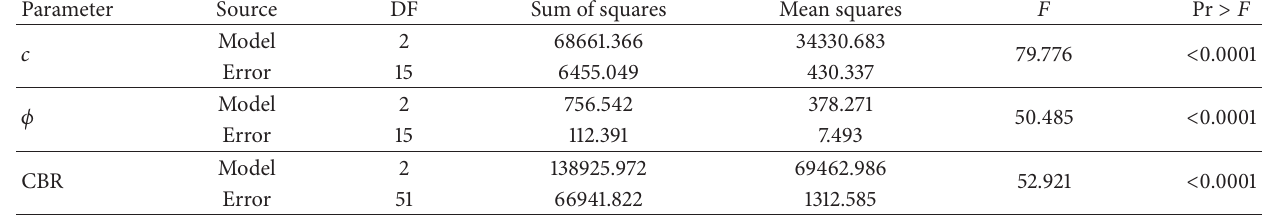
Table 5: ANOVA of 𝑑 and FA for dependent variable ( 𝑐 - 𝜙 and CBR).